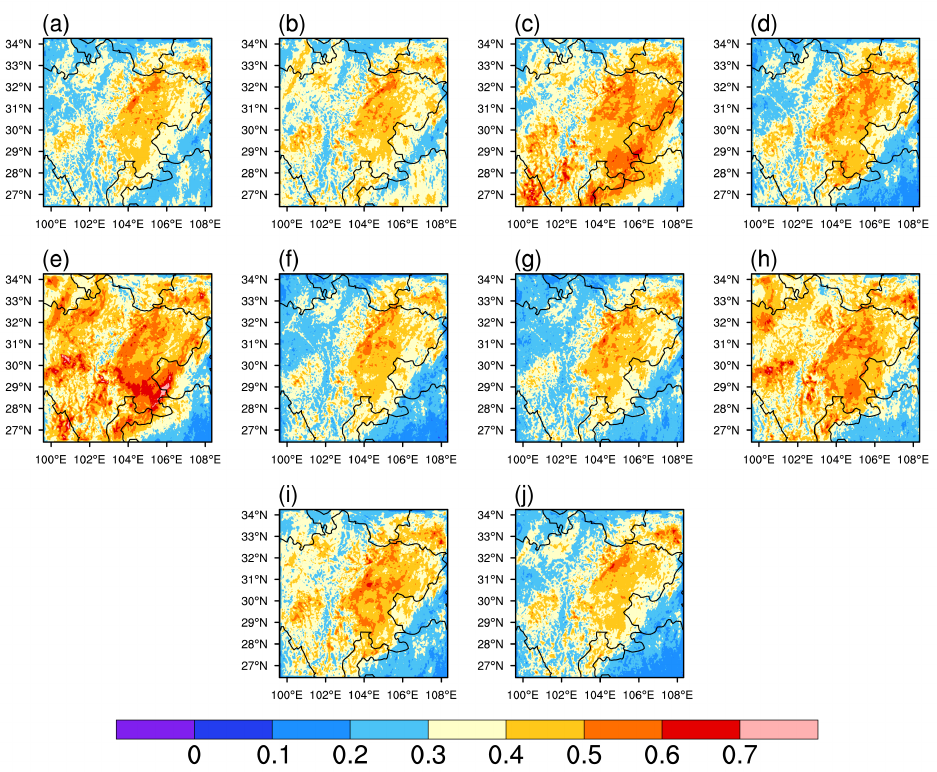
Figure 19. Similar to Figure 18, but for the period of 00:00 UTC to 11:00 UTC.